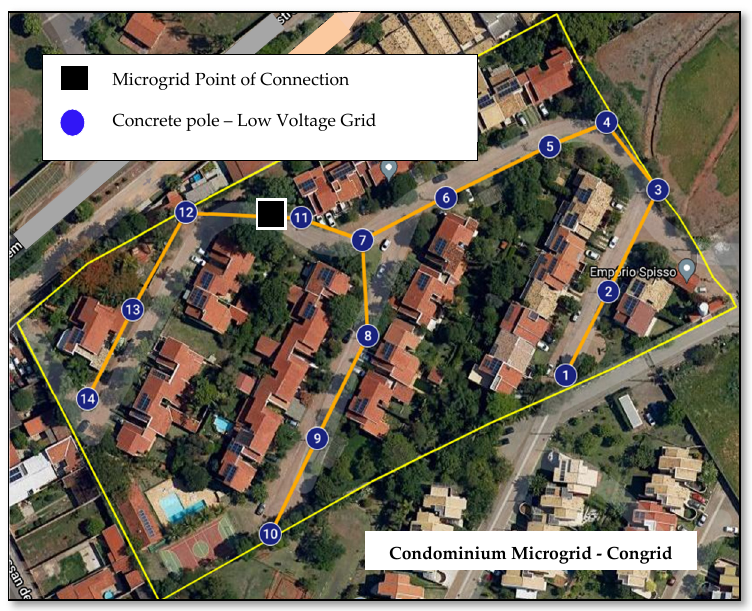
Figure 5. Point of connection diagram of condominium microgrid installation with central ESS con- nected to the secondary distribution network.